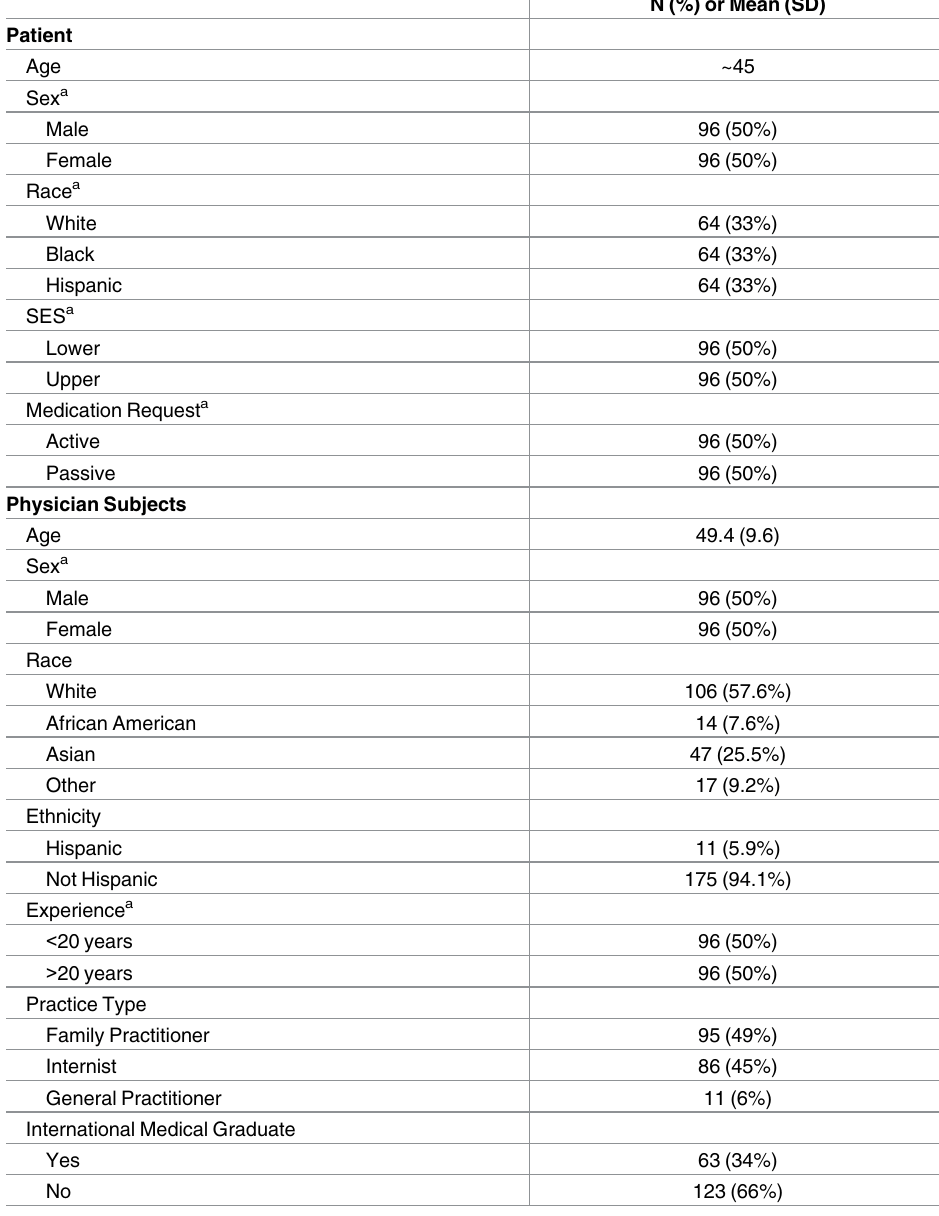
Table 1. Patient (simulated) and physician characteristics, N =